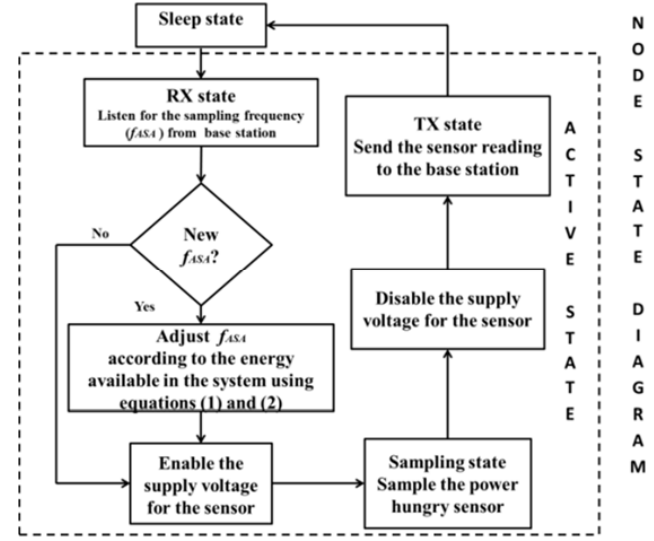
Figure 1. State flow diagram of a duty cycled node that has harvesting capabilities and uses a power hungry sensor-deployment (I).